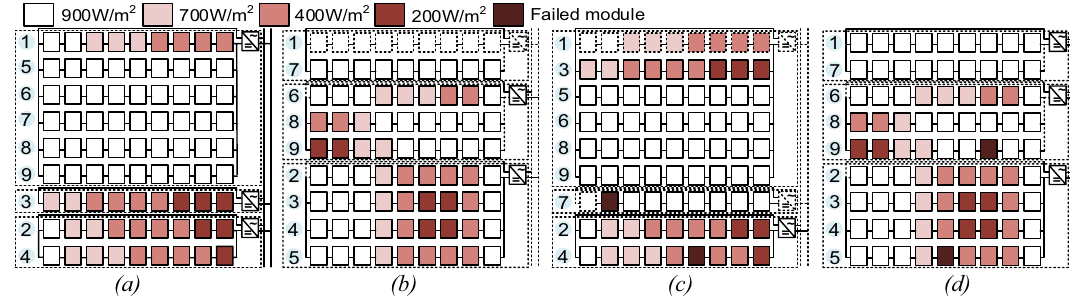
Fig. 13 Arrangement after dynamical reconfiguration for SP-based PV array ( a ) Scenario 1; ( b ) Scenario 2; ( c ) Scenario 3; and ( d ) Scenario